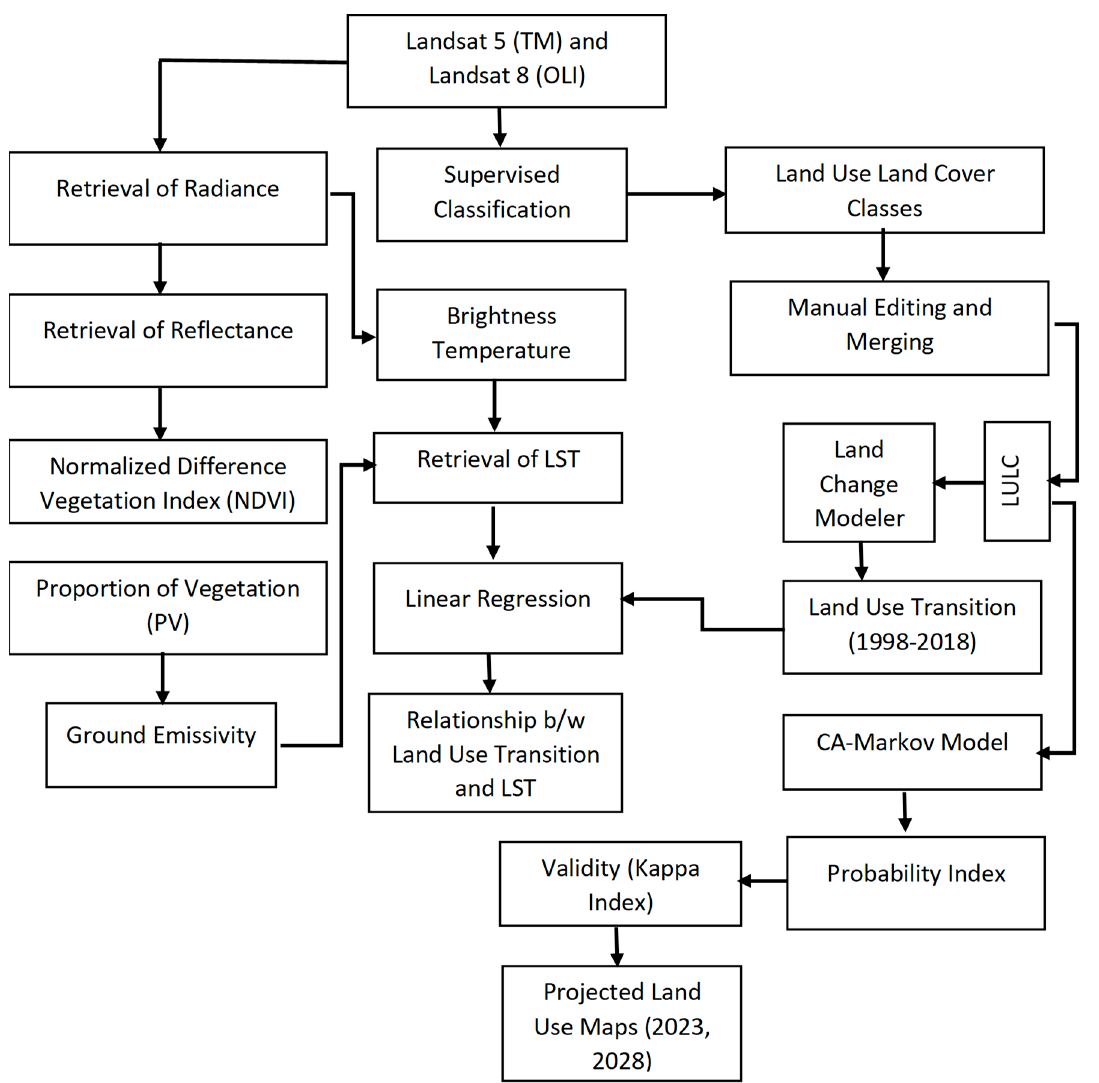
Figure 2. Flow chart visualizing the data preprocessing and analysis methodology. Table 1. Satellite images used in this study.